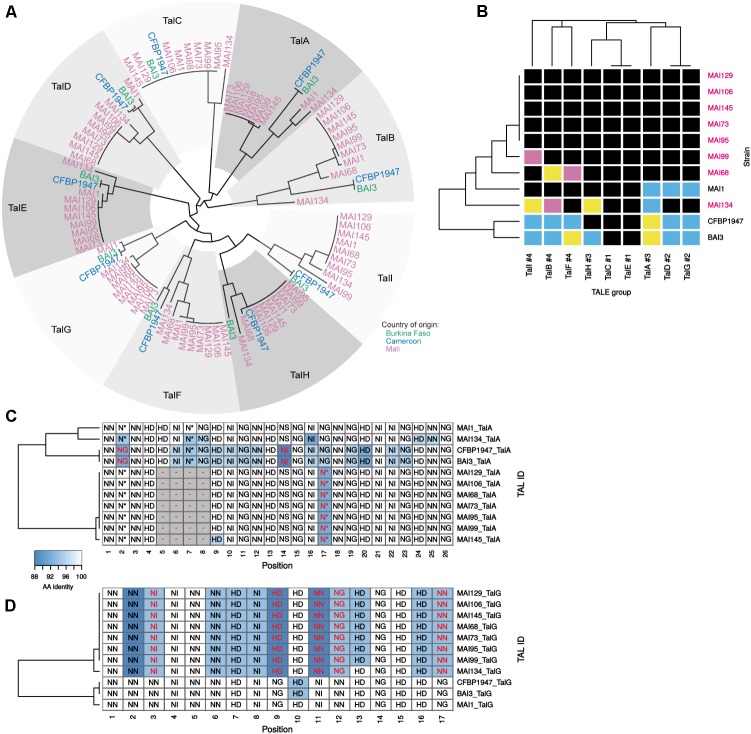
In silico analysis of the diversity of tal genes content of Malian strains. (A) DisTAL neighbor-joining phylogenetic tree and group classification of tal genes. All detected tal genes in available complete genomes of African strain (colored tip labels) were assigned to one of the previously defined African TALE groups (Tran et al., 2018) (gray level colored sectors) based on their position in the tree topology. (B) Diversity of African Xoo strains TALE RVD sequence variants in each TALE group. Within each TALE group (columns) and across strains (rows), individual cell colors code for distinct TALE RVD sequence variants. The number following the pound sign in the label of the TALE groups designates the total number of unique variants found for this group in this genome set. Malian strains whose genome was determined in this work are labeled in pink. Multiple alignments of the African TALE central repeat regions based on DisTAL repeat unit sequences for the TalA (C) and TalG (D) groups. Cell coloring reflects amino-acid identity between each repeat and the MAI1 TALE repeat at this position that was used as a reference. Each cell is labeled with the RVD encoded by the corresponding repeat. RVDs that are different from the corresponding MAI1 reference at this position are colored in red font. Gaps introduced to maximize the alignment score are colored in gray.